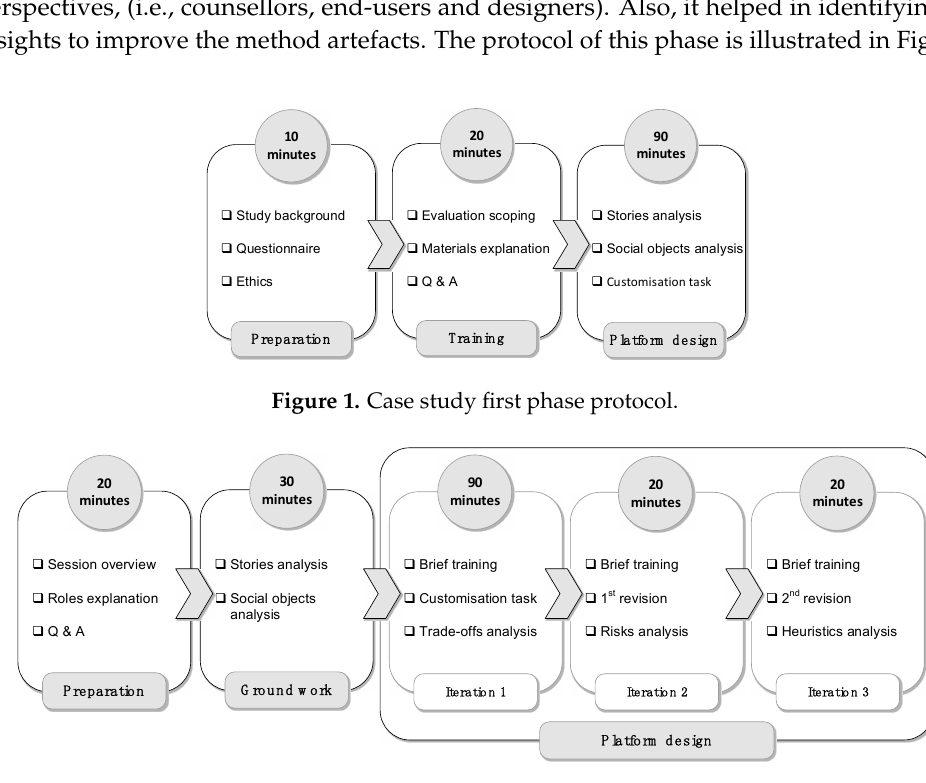
Figure 2. Case study second phase protocol.